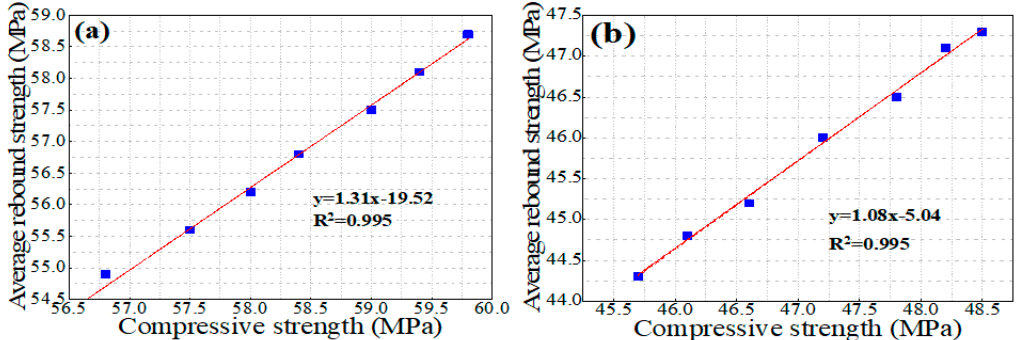
Figure 4. Linear relationships between compressive strength and average rebound strength for concrete in the marine and land sections. ( a ) Marine section; ( b ) Land section.